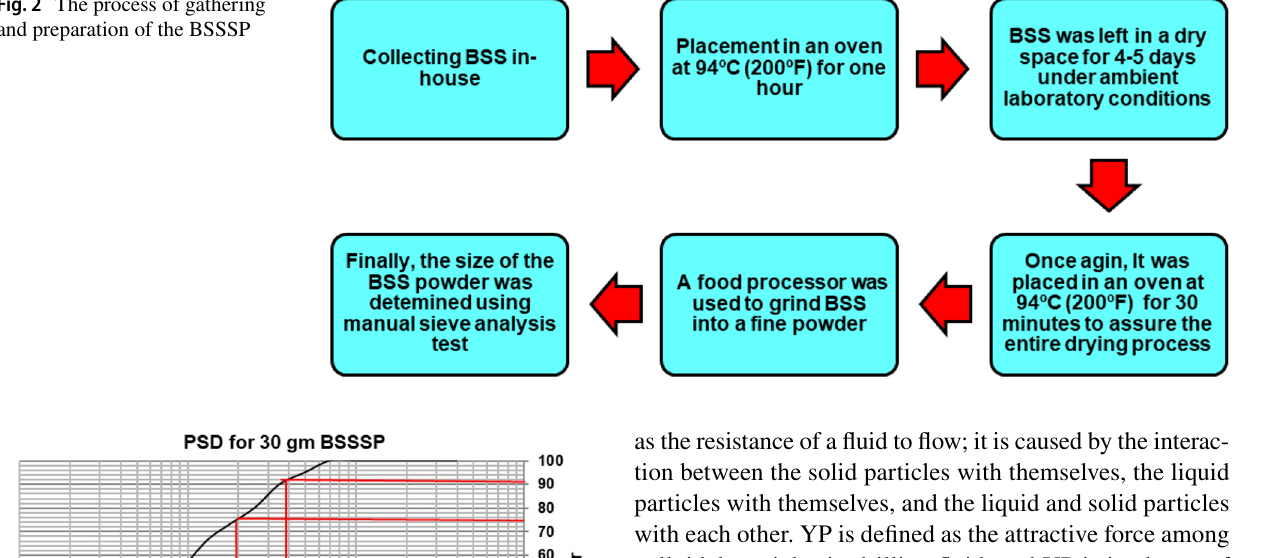
Fig. 2 The process of gathering and preparation of the BSSSP